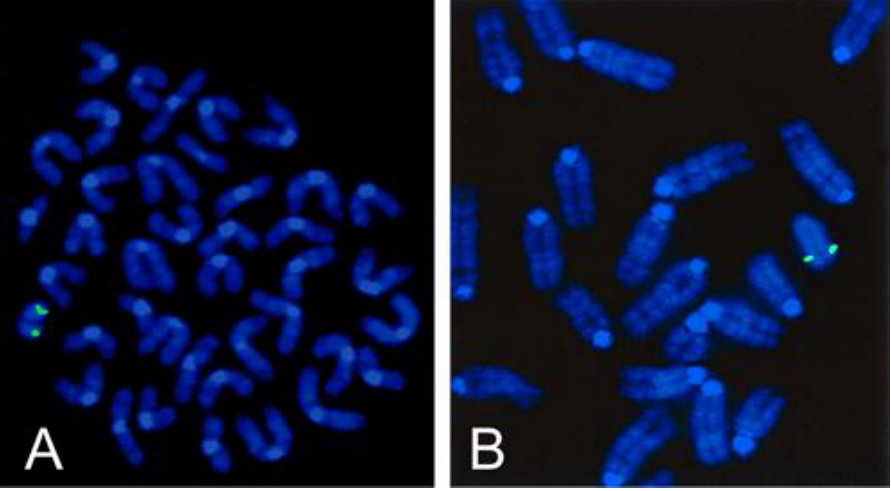
Figure 1. Fluorescence In Situ Hybridization analysis of a biotin-deoxyuridine 5-triphophate-labeled human TSPY probe (pHerbi) to DAPI counterstained chromosomes (A, B) of a TSPY transgenic adult mouse of the transgenic line Tg(TSPY)9Jshm . The recombinant plasmid pHerbi contains the human 8.2 kb genomic TSPY fragment that was used to generate the TSPY transgenic line Tg(TSPY)9Jshm [47]. Figure 1B was originally published in Schubert et al. , 2003